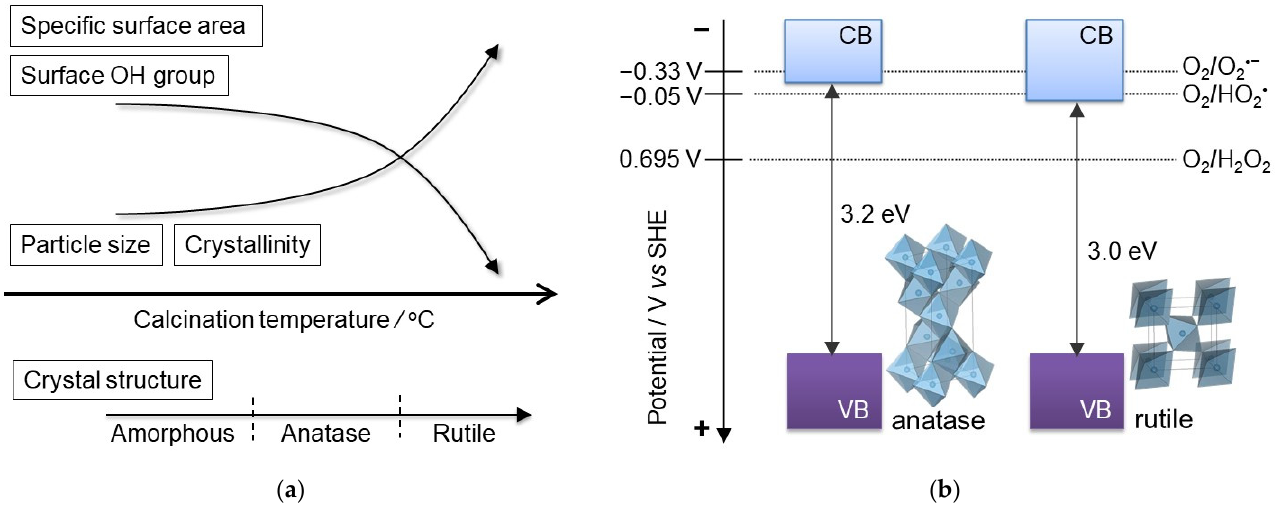
Figure 1. ( a ) Effect of calcination temperature on the properties of TiO 2 . ( b ) Schematic energy dia- gram of anatase and rutile TiO 2 and the standard electrode potentials for the oxygen reduction reaction. The conduction band (CB) minimum positions were assumed from the reported flat band potentials, and the valence band (VB) maximum positions were derived from their band gap energies.